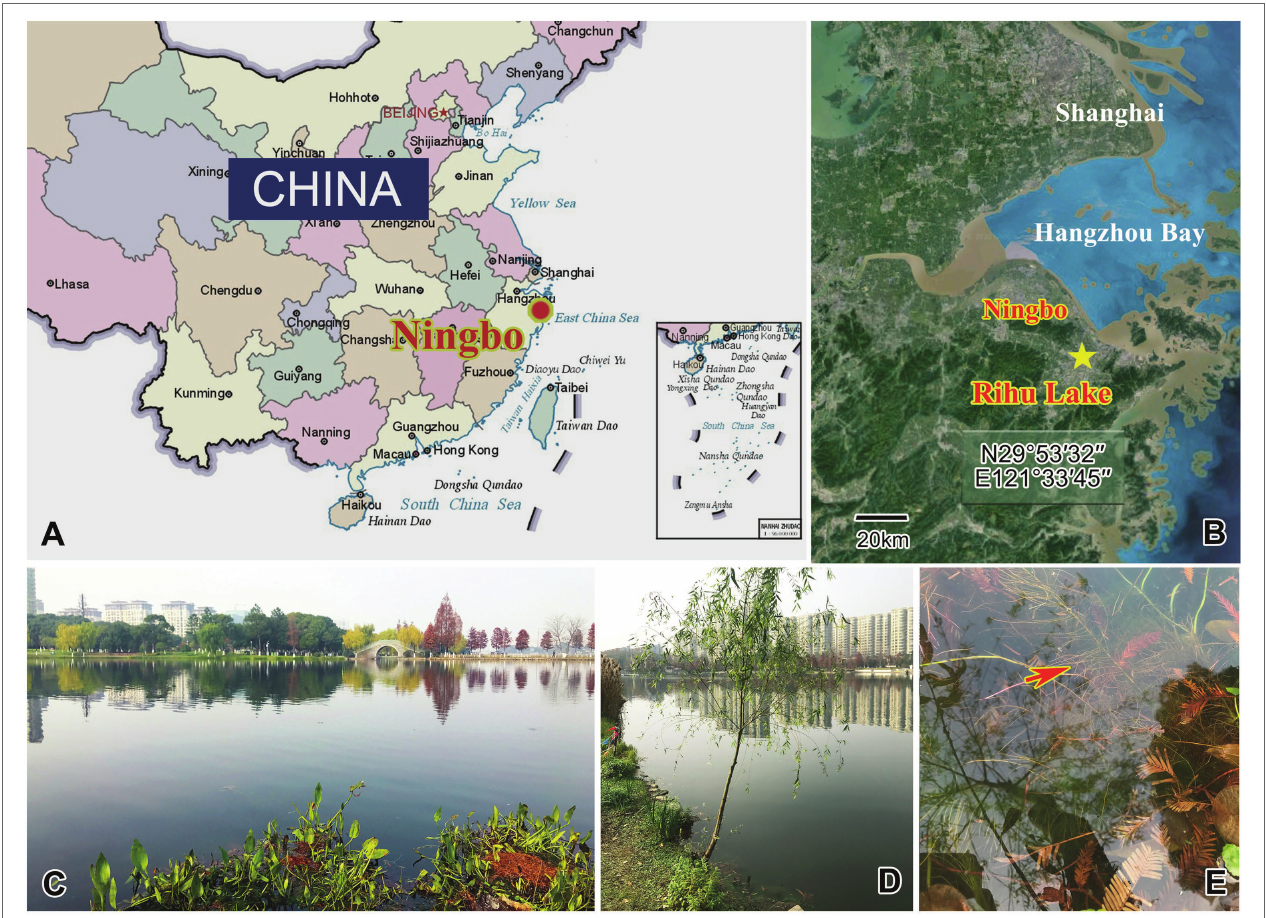
FIGURE 1 | Maps and photographs of the sample site. (A) Location of Ningbo. (B) The star indicates the location of the sample site (29 ° 53 ʹ 32 " N, 121 ° 33 ʹ 45 " E). (C) Landscape of Rihu lake. (D) Suctorians were isolated from the root of this willow. (E) The red arrow showing the fibril of the